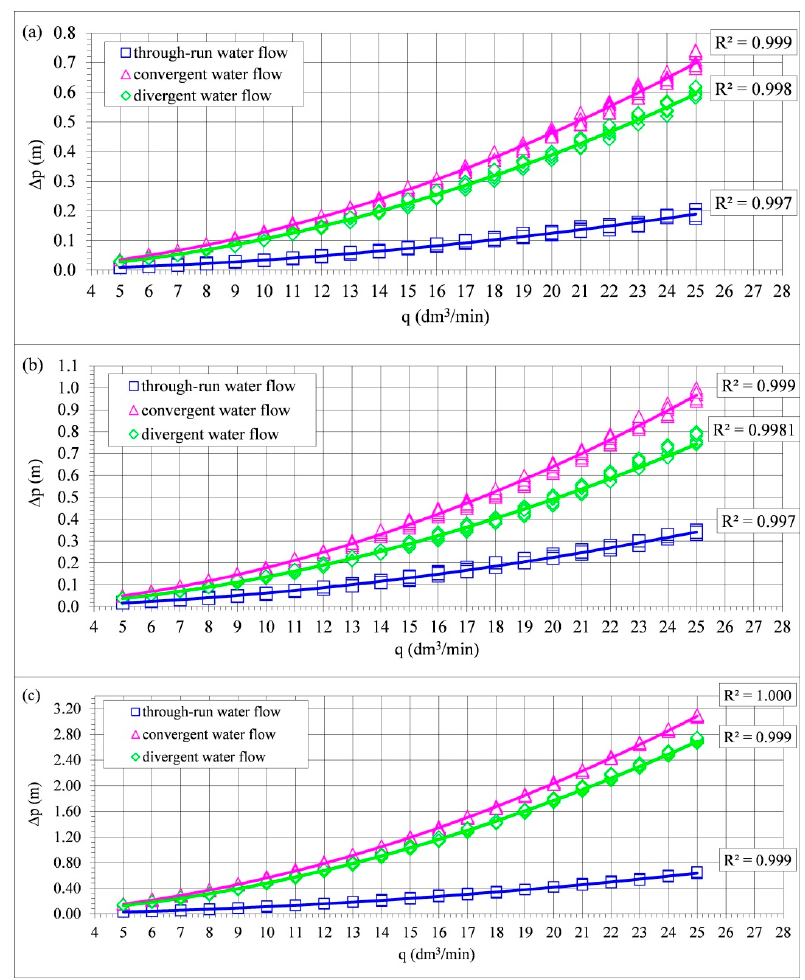
Figure 4: Dependence between the real pressure difference Δ p in polypropylene T-junctions with an internal diameter of 13.2 mm and the water flow rate q: ( a ) properly warmed up and properly pressed T-junction, ( b ) poorly warmed up and poorly pressed T-junction, ( c ) excessively warmed up and excessively pressed T-junction.